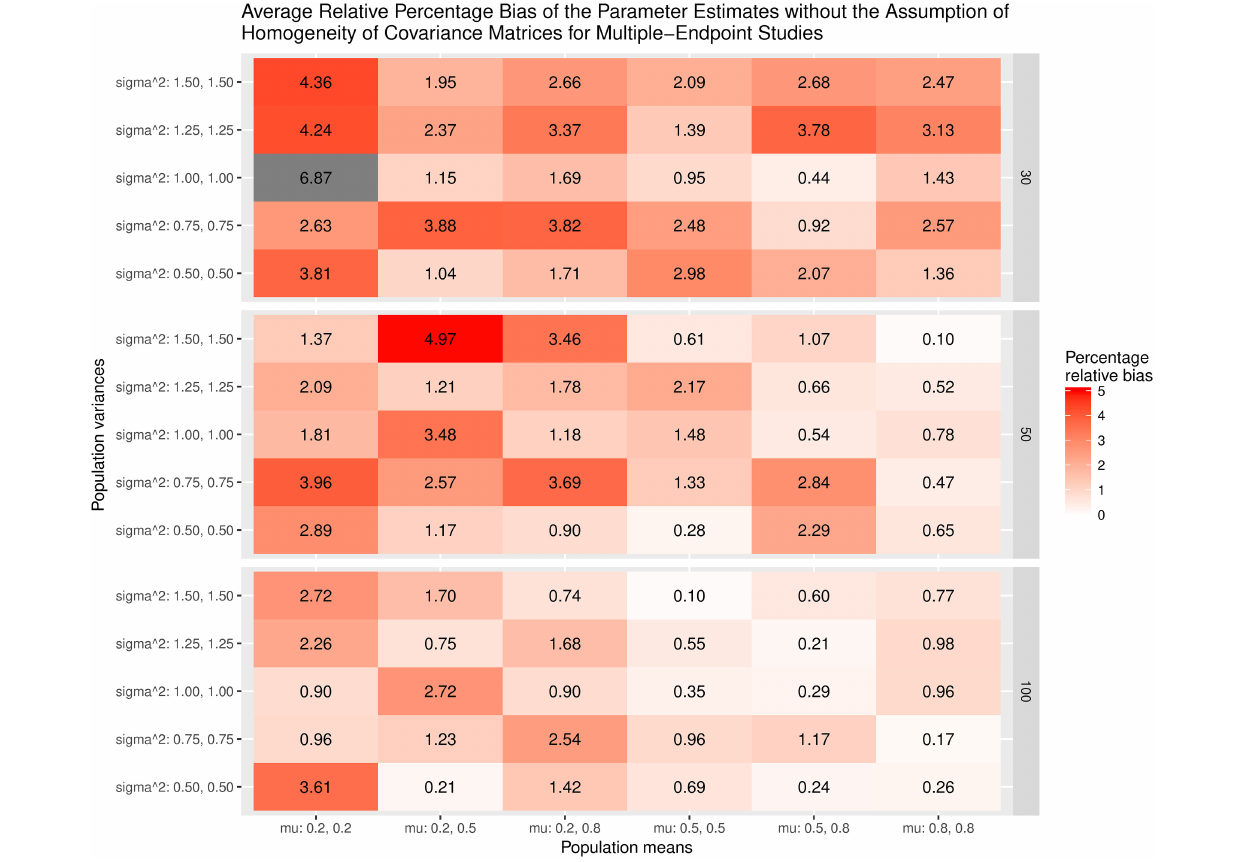
Frontiers in Psychology |